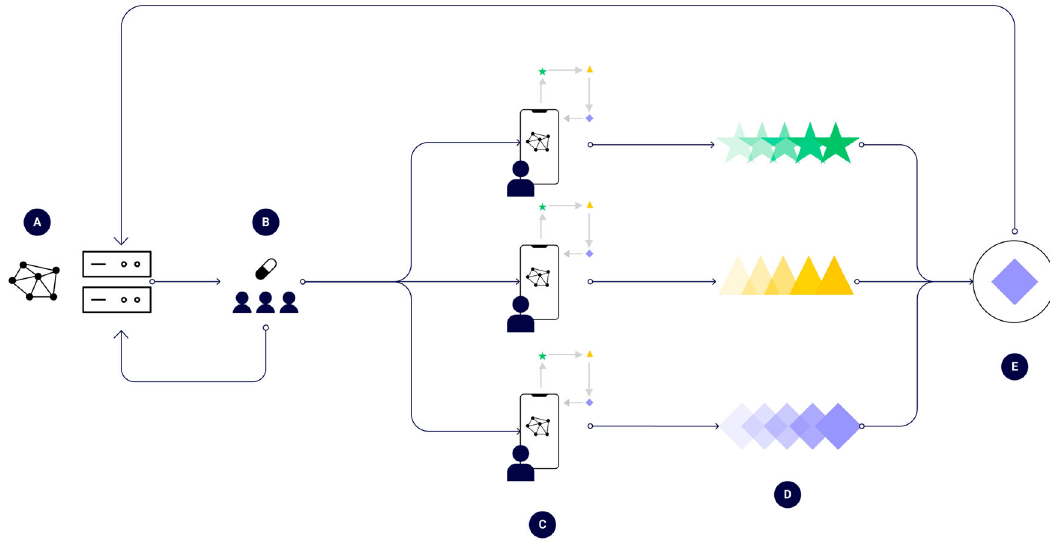
Fig. 1 Process diagram for the decentralized execution of federated clinical trials. A A protocol is created and is digitally disseminated to consenting participants-to-be in a DCT, B Participants in a DCT are randomly exposed to a medical intervention, C Participants process their own data (e.g., digital biomarkers), D Findings are aggregated from each participant, and E The overall effect of the intervention is estimated as overall estimate, aggregated, and sent